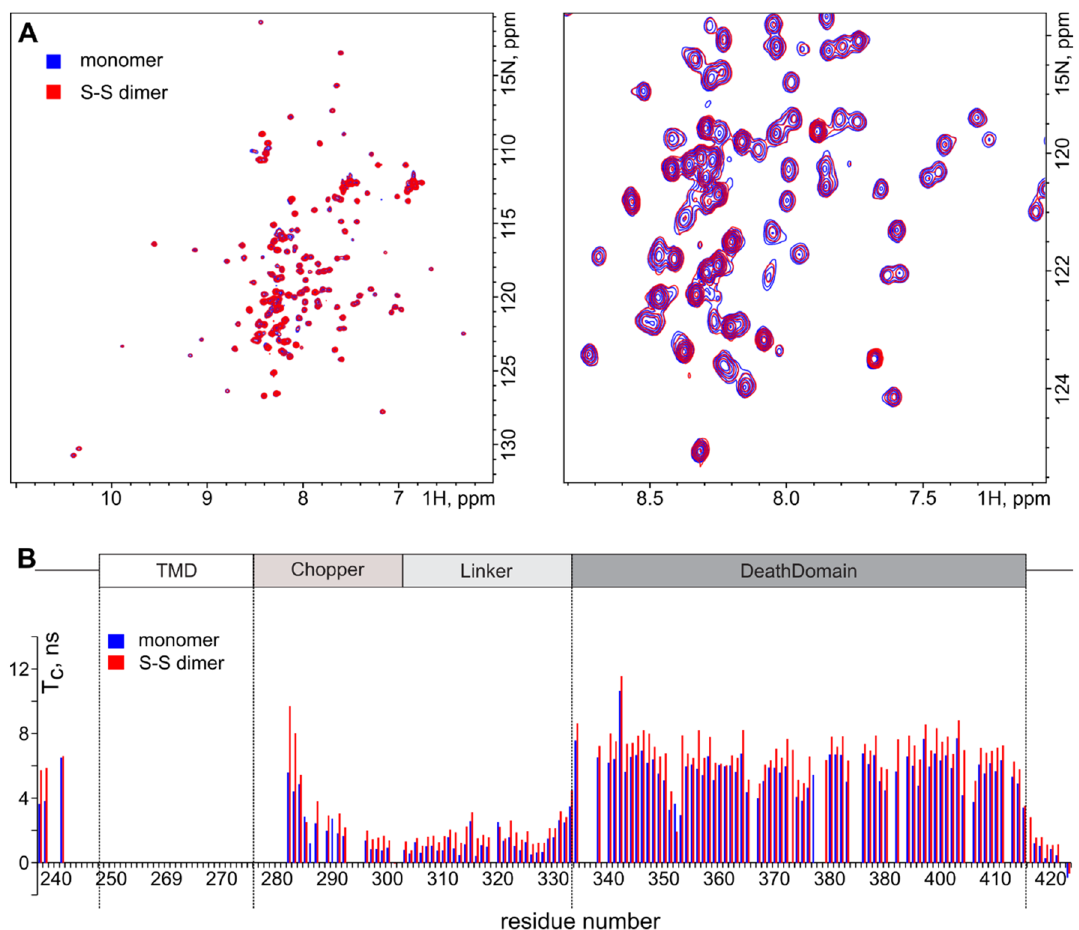
Figure 5. The effect of dimerization on the structure and behavior of the intracellular domain of rP75-ΔECD- 3CX. ( A ) 1 H, 15 N-HSQC spectra of rP75-ΔECD-3CX monomer (shown in blue) and disulfide-crosslinked dimer (shown in red). The full spectrum and central region are shown at left and right, respectively. ( B ) NMR-derived rotational diffusion correlation time of N–H bonds is plotted versus the residue number of rP75-ΔECD-3CX monomer (blue bars) and dimer (red bars). The figure was prepared using the program Inkscape 0.92 (https :// inksc